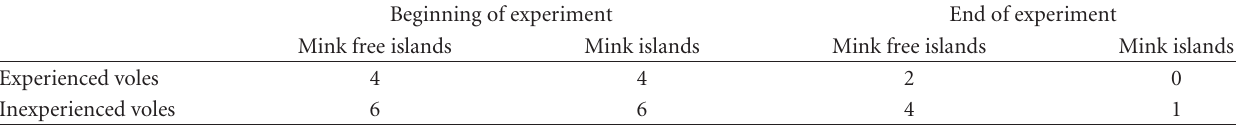
Table 1: Number of voles released at the beginning of the experiment and survivors at the end of the